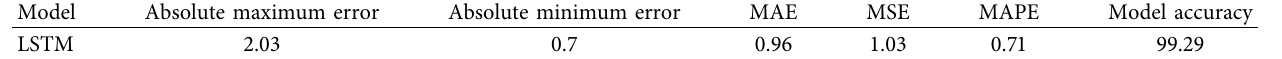
Table 3: Prediction error and accuracy results of the LSTM model.